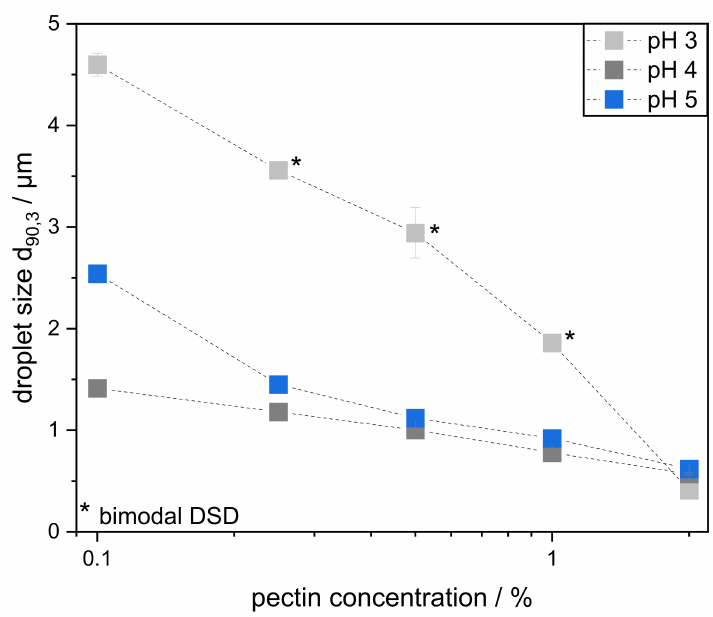
Figure 4. Characteristic droplet size d 90,3 of emulsions prepared with 10 wt% MCT oil and varying pectin concentration of 0.1–2.0 wt% at different pH levels (3, 4, and 5). The emulsions were prepared with a high-pressure homogenizer at 400 bar and in a second pass at 800 bar. * Emulsion with bimodal droplet size distribution